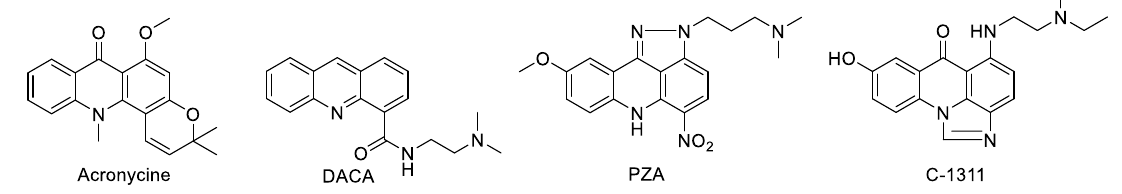
Figure 1. Structures of acronycine, DACA, PZA and C-1311.